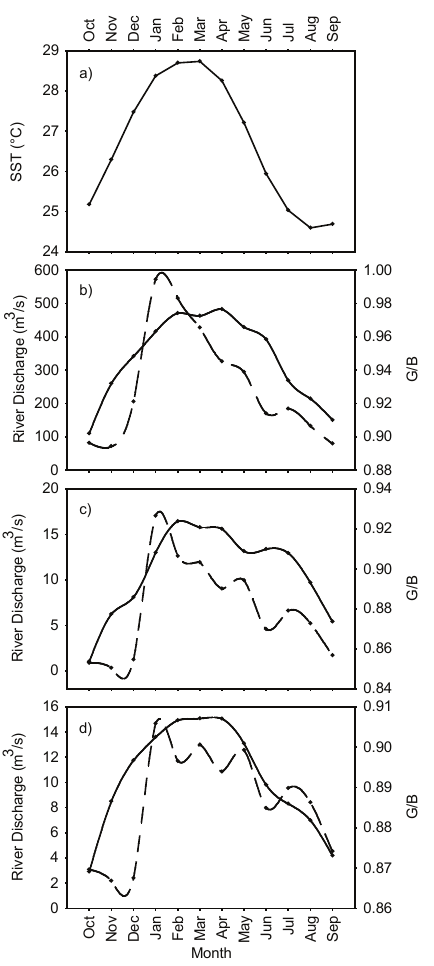
Fig. 2. Average seasonal cycle of SST (a) (ERSST; Smith et al., 2008) for Antongil Bay (52 ◦ E, 16 ◦ S) calculated by averaging ev- ery month over a 15yr period (1991–2005). Similarly, over the same 15yr period, the average seasonal G/B (solid line) and modelled river discharge data (dashed line) are calculated for the corals (b) MAS1, (c) ANDRA and (d) IFAHO and their closest respective rivers (b) the Antainambalana River, (c) the Ambanizana River and (d) the Anaovandran